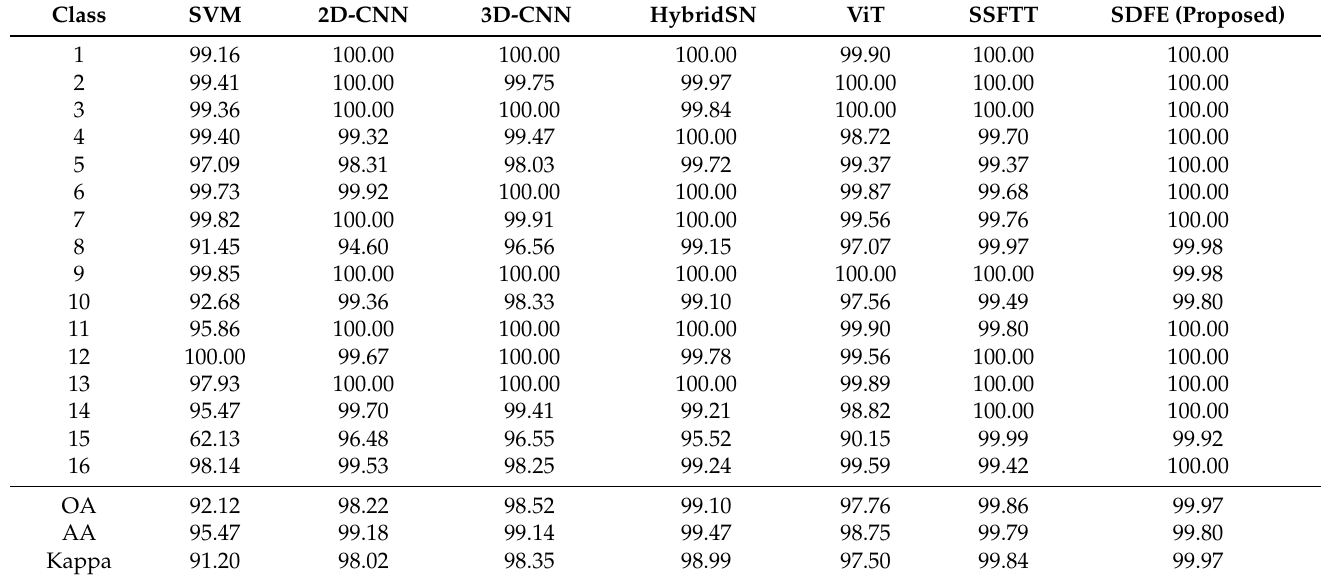
Table 12. The classification results (in percent) using SDFE and other baselines for the SA